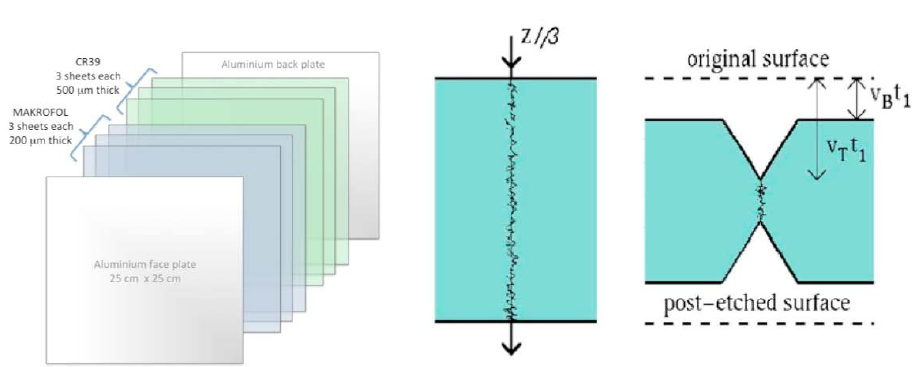
Figure 3. (Left) A MoEDAL stack comprised of CR39 and Makrofol NTD detectors. (Right) the damage zone